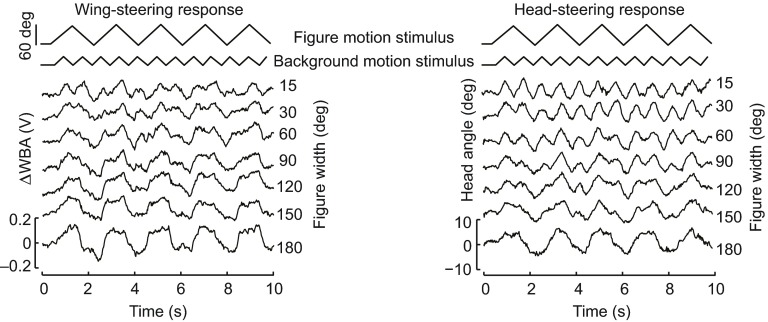
Influence of varying figure width on head and wing responses to triangle-wave figure and ground stimuli. For the same experiment described in Fig. 4, and only for the figure centered on midline, the horizontal width of the figure was systematically varied from 15 to 180 deg. Each plotted trajectory is the mean response for N=15 flies. Note that for even the smallest width figures, the wing-steering trajectories contain components of both the figure and ground stimuli, whereas the head trajectories follow only the ground component.